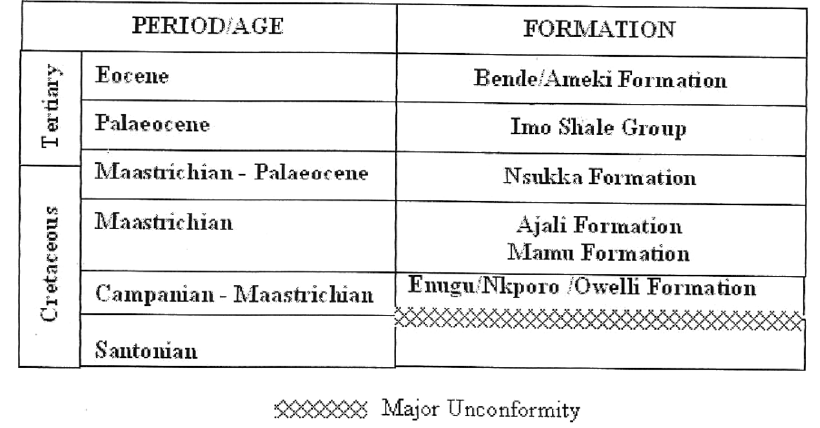
Fig. 2 Generalised stratigraphic sequence of Anambra